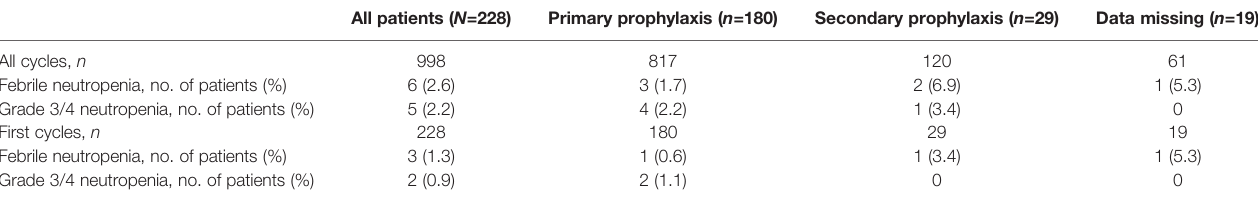
TABLE 4 | Incidence of febrile neutropenia and neutropenia over all cycles and in the fi rst cycle according to intention of lipeg fi lgrastim treatment. All patients ( N =228) Primary prophylaxis ( n